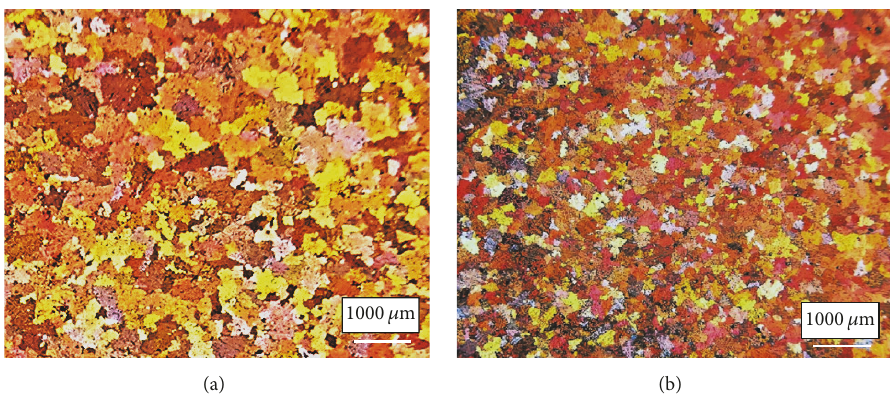
Figure 7: Grain size and distribution in base alloy containing (a) 0.05 wt% Ti-500 𝜇 m and (b) 0.15wt% Ti-200 𝜇 m.